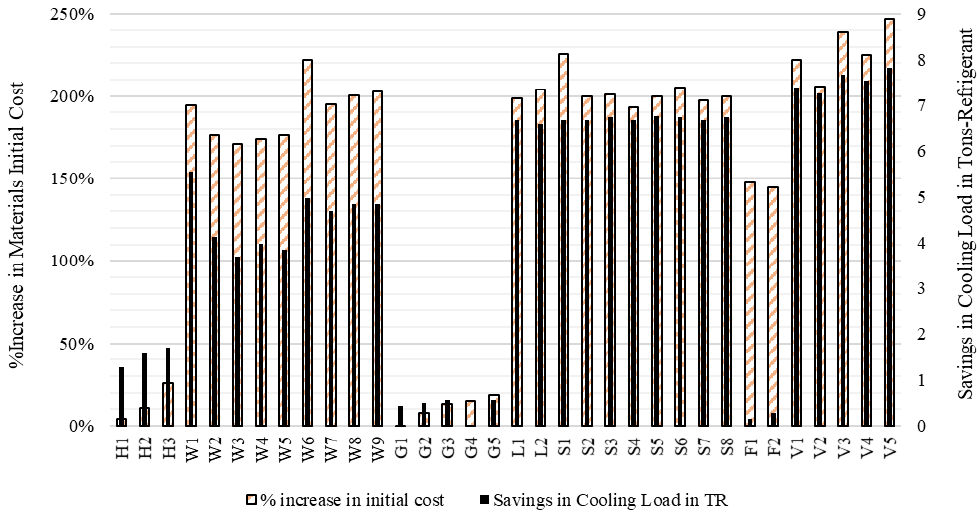
Figure 5. The percent increase in the initial cost and savings in cooling loads w.r.t. BC case.